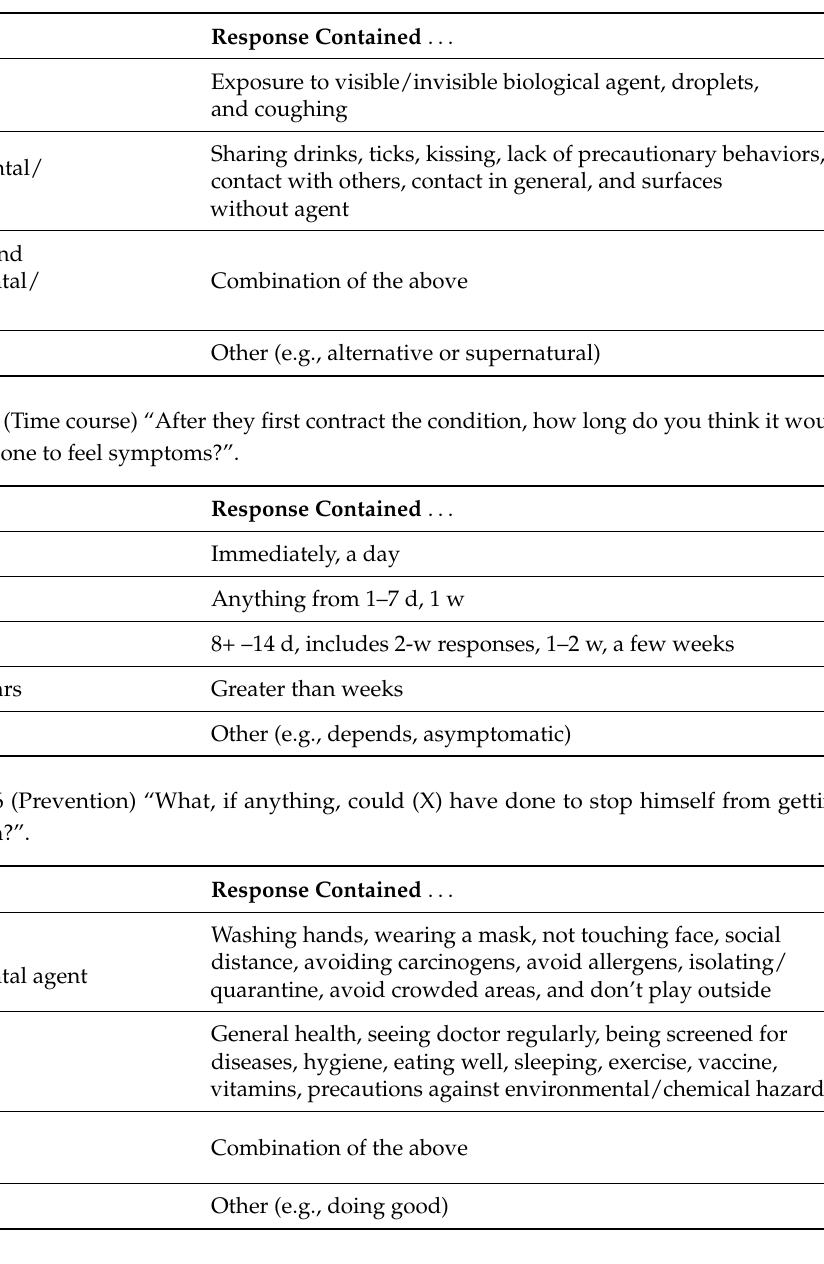
Table A5. Q7 (Treatment) “What, if anything, would make (X) feel better? Is there a cure for someone with this